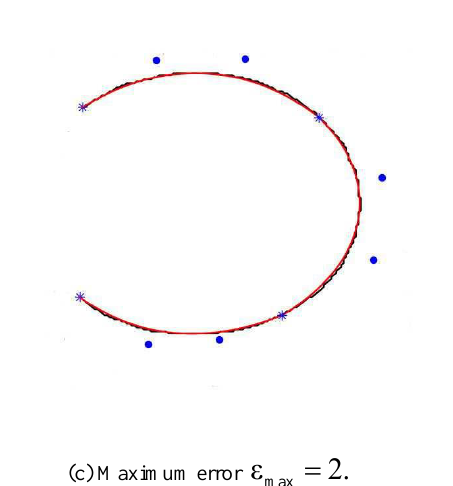
Figure 2. Fitting a non-parametric curve (black) using a cubic Bezier curve (red) with the proposed